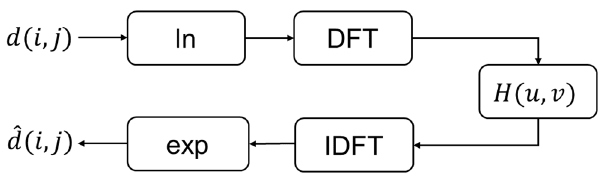
Figure 2. Homomorphic filtering. The input d ( i , j ) and the output ˆ d ( i , j ) are the unprocessed and filtered images, respectively. The components include logarithmic transformation (ln), 2D discrete Fourier transform (DFT), Gaussian high-pass filtering [ H ( · )], 2D inverse discrete Fourier transform (IDFT), and exponential transformation (exp).